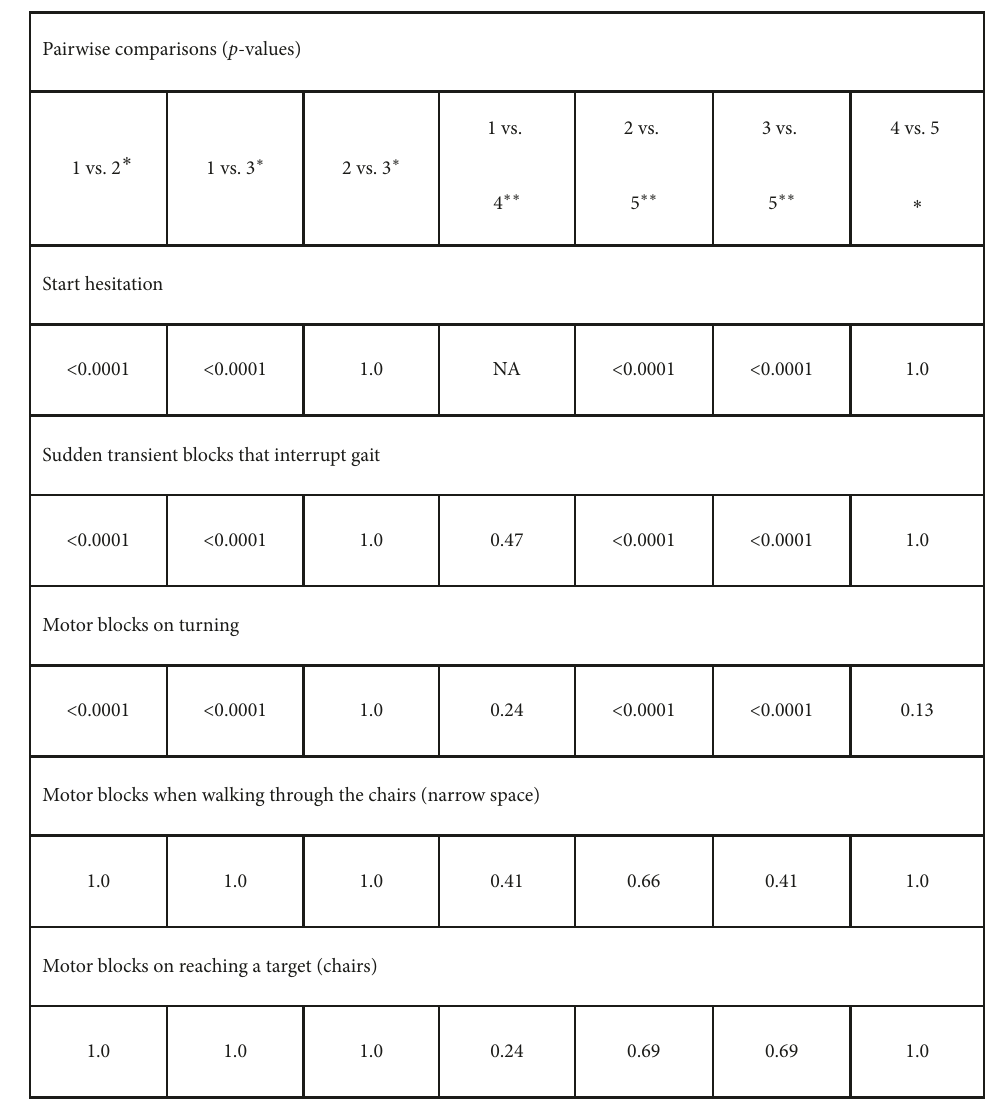
Figure 3: Results of the Provocative Test for Motor Blocks. (a) Number of patients in each group affected by a particular symptom at different timepoints; significant differences are marked in red. (b) Results of pairwise comparisons between the groups/timepoints; timepoint numbering is explained in